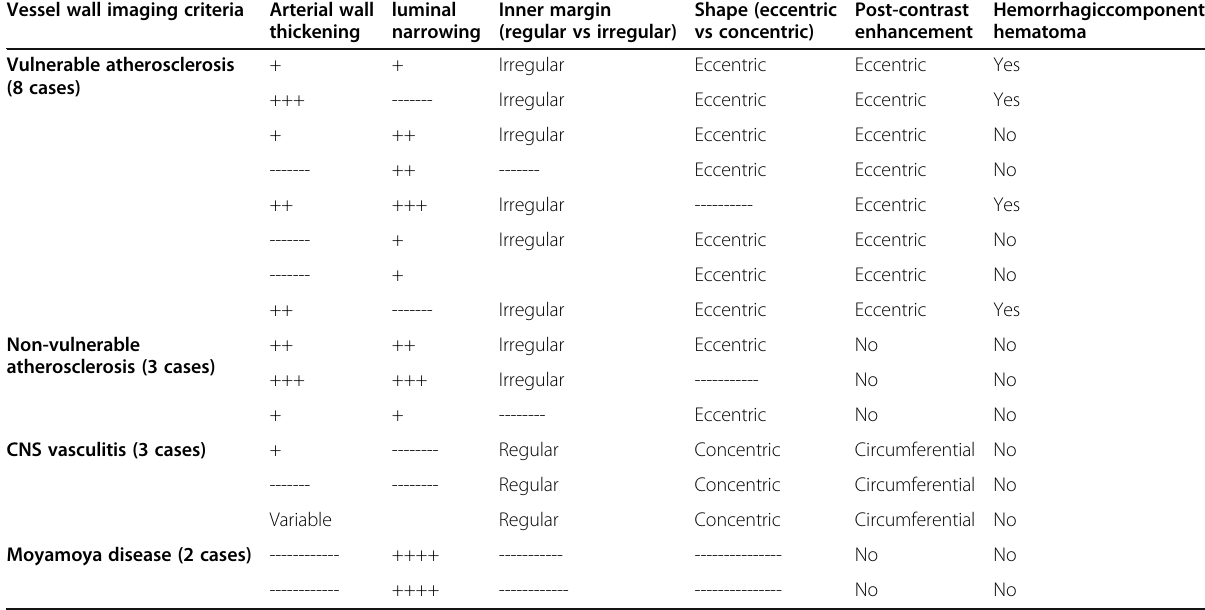
Table 3 Intracranial vessel wall imaging findings among the study groups Vessel wall imaging